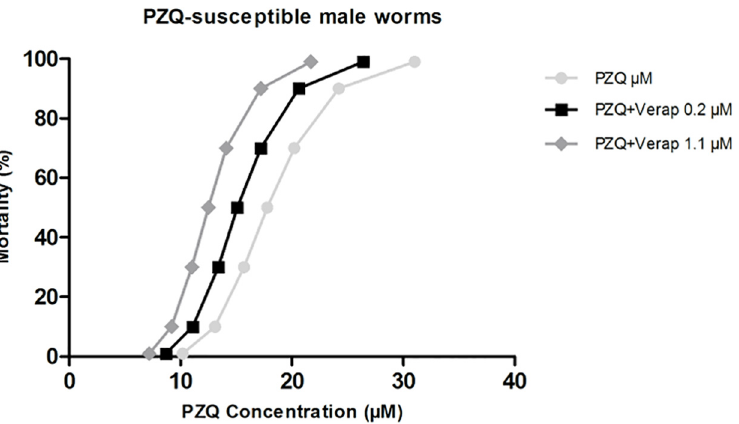
Fig 9. Mortality trends of S . mansoni adult males PZQ-susceptible exposed to PZQ in the presence of Verapamil. The mortality levels to increase concentrations of Verapamil (0.2 and 1.1 μ M) are represented by survival curves. Additionally, the survival curve of parasites unexposed to Verapamil is also represented. The Probit regression model was used with a 95% of confidence.